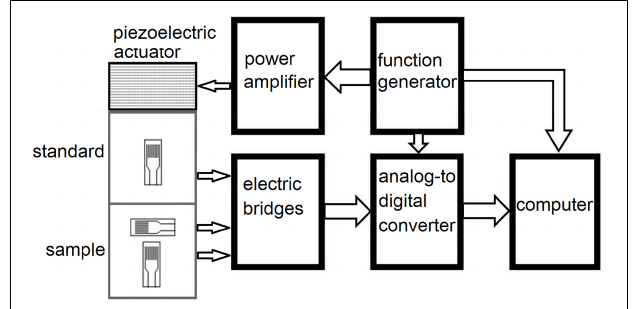
FIGURE 2 | The electrical schematics of the seismic frequency laboratory apparatus.